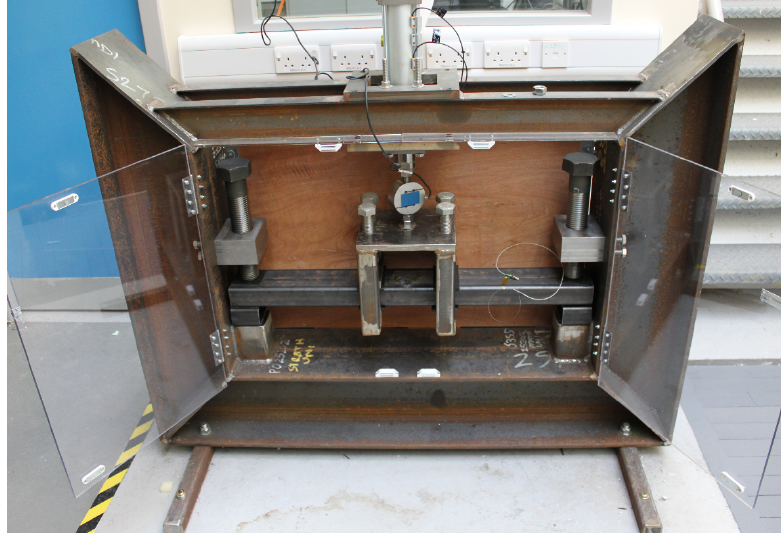
Figure 8. Experimental set-up of test specimen.